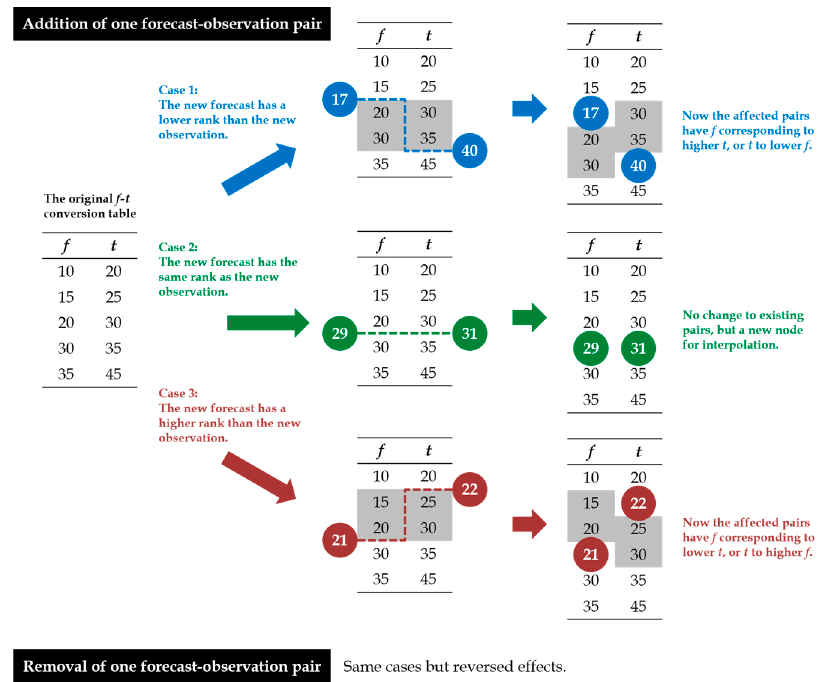
Figure 4. An illustration of the effects on the f-t conversion table considering just an addition or removal of one forecast–observation pair for the Sliding Window method. Values shaded in grey are original f - t pairs which get affected. A removal shares the same cases as an addition but with reversed effects.